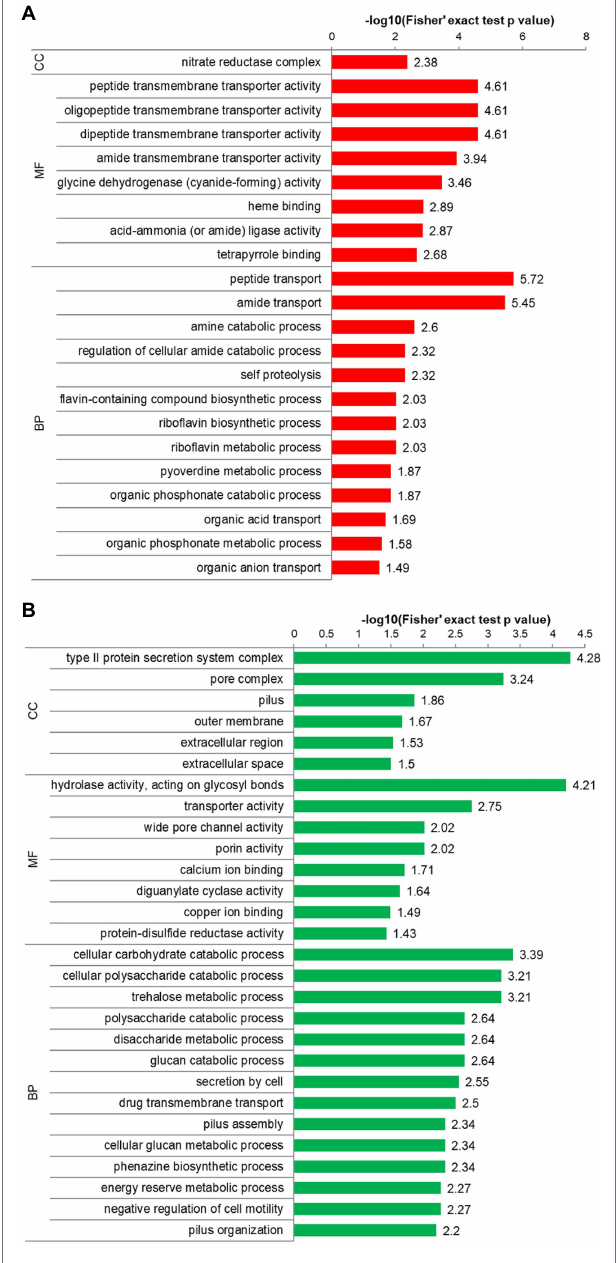
FIGURE 4 | GO enrichment analysis. (A) GO enrichment results for upregulated proteins. (B) GO enrichment results for downregulated proteins. The y axis denotes the GO functional classification enriched by the differentially expressed protein, and the x axis denotes the − log 10 of the value of p of Fisher’s exact test of the significance of the enrichment. BP, biological process; CC, cellular compartment; and MF, molecular